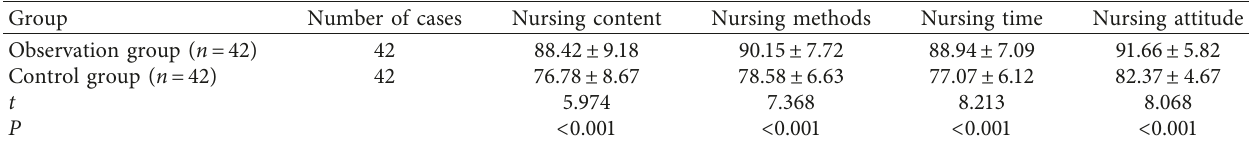
Table 3: Comparison of nursing satisfaction between the observation group and the control group (score, x ± s).